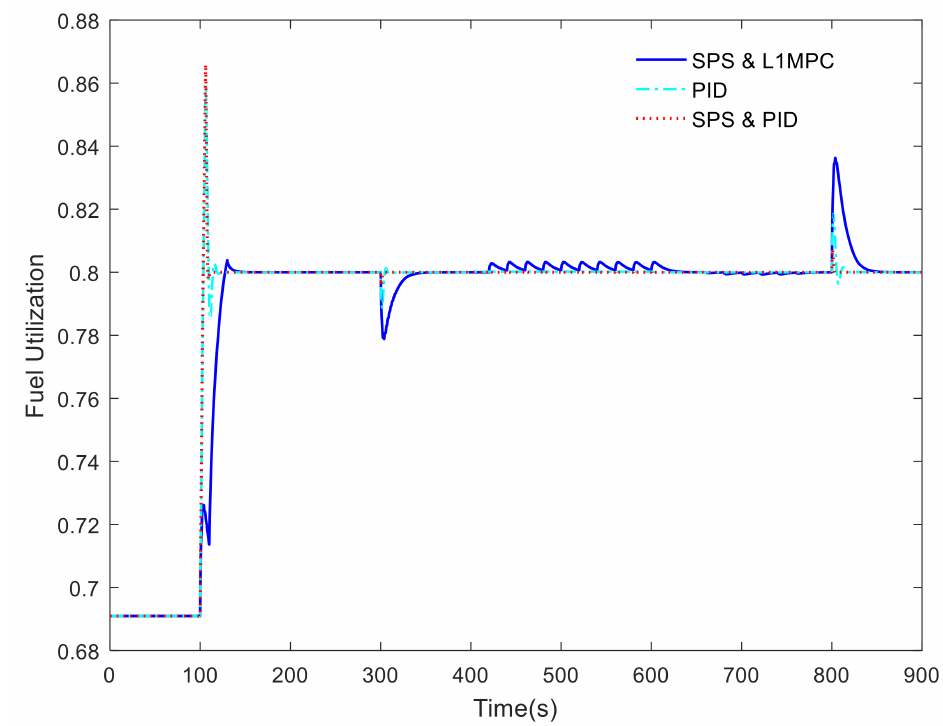
Figure 11. The fuel utilization of SOFCs.